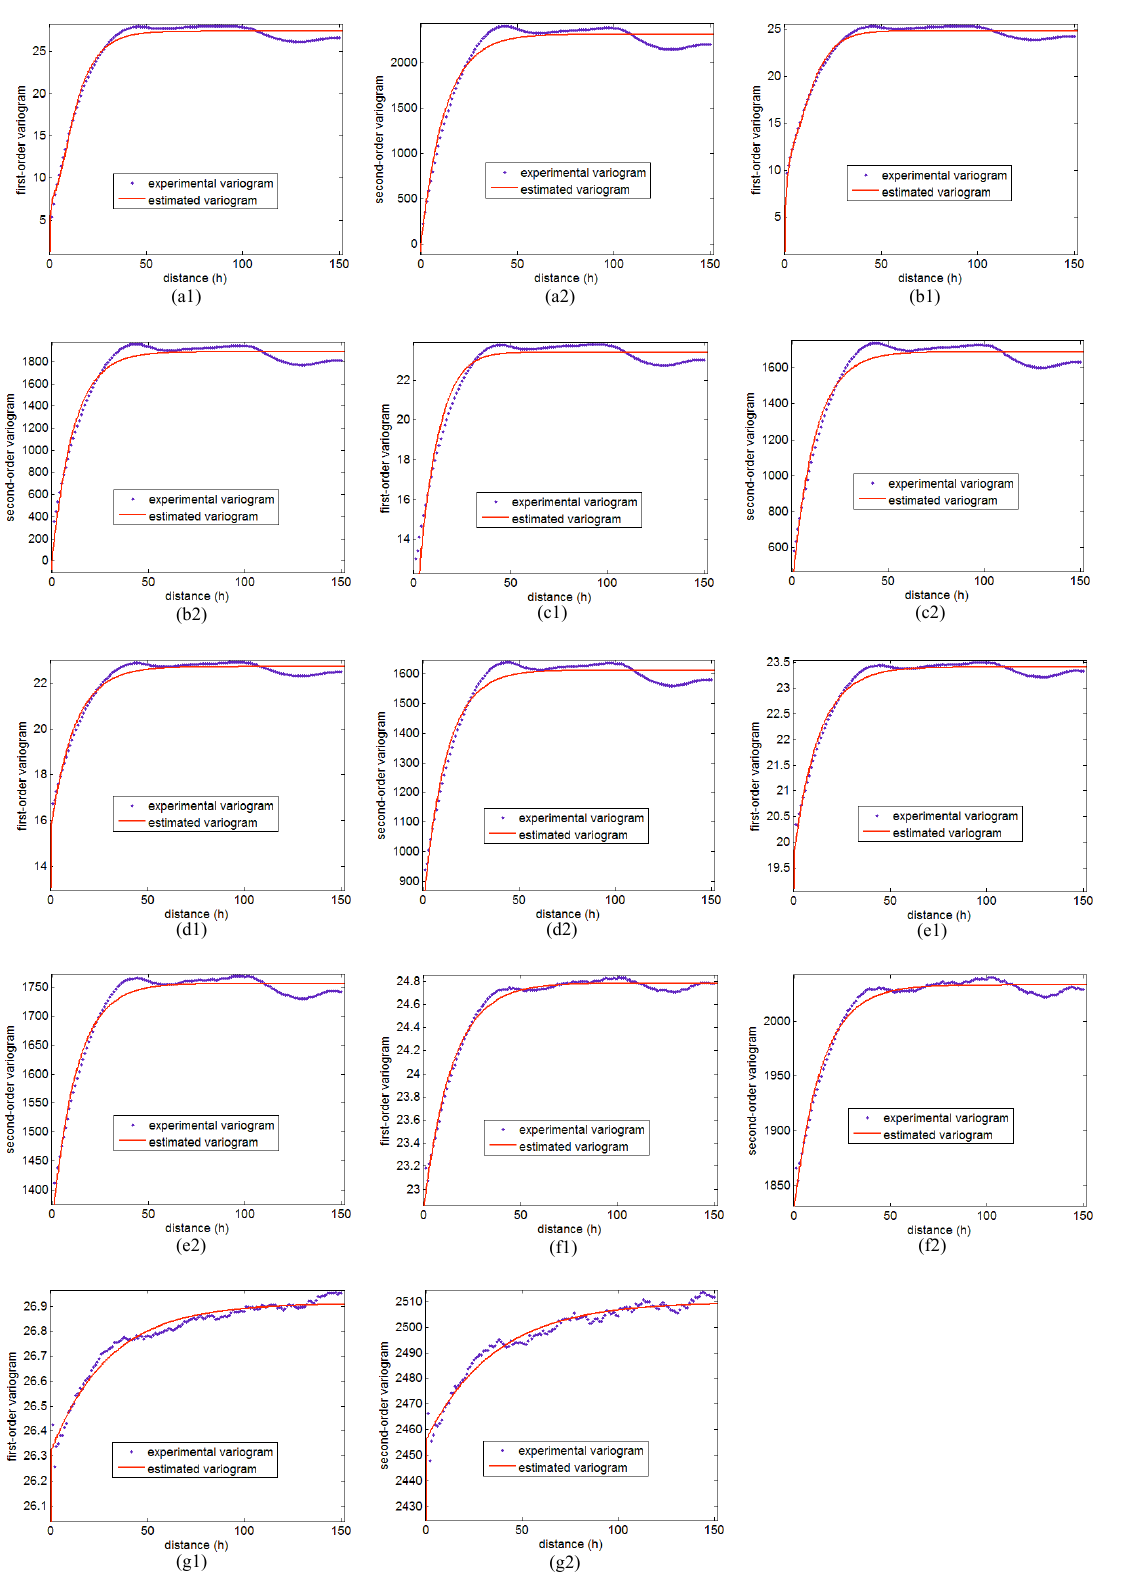
Fig.7 Result of the estimations of the first-order and second-order variograms from the simulated images. From (a) to (g) are corresponding to Z 1 ( x ) to Z 7 ( x ). From (a1) to (g1) are first-order variograms and from (a2) to (g2) are second-order